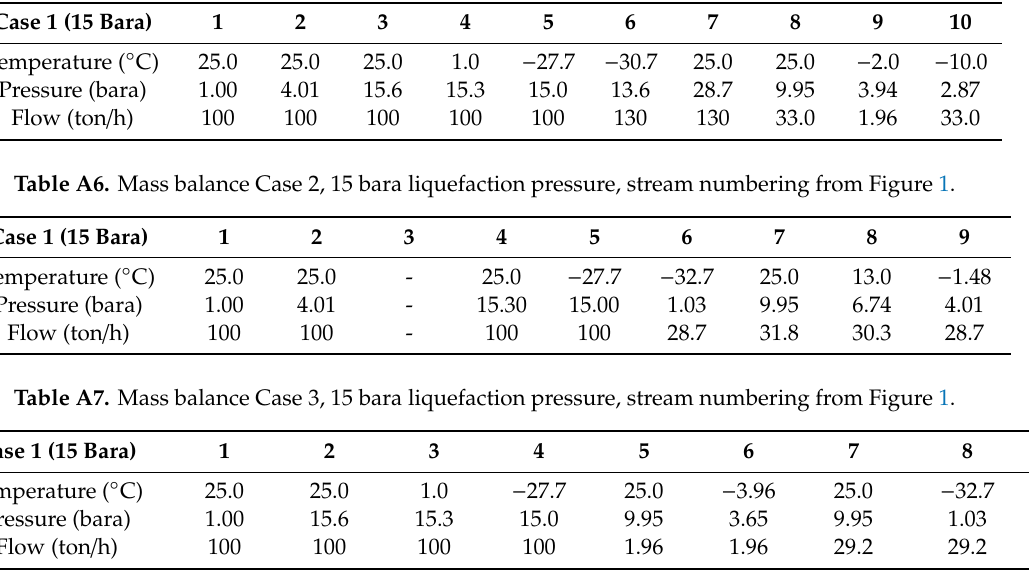
Table A5. Mass balance Case 1, 15 bara liquefaction pressure, stream numbering from Figure 1.